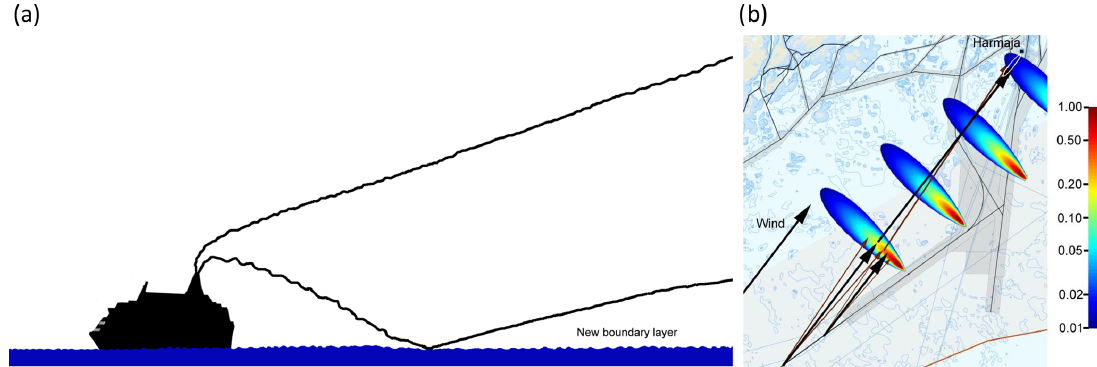
Figure 10. (a) Schematic figure of the vertical profile of ship plume dispersion. If the stack height is around 55m, the plume touches the sea surface at a distance of around 450m from the ship. Panel (b) shows the momentary plumes at 15, 23, 30, and 37 min after start (0min) at the sea surface. The black arrows are the wind speed (ws) vectors (ws = 11ms − 1 ), the brown arrows show the dispersion of the plume, and the gray lines are the ship routes to Helsinki, with one passing Harmaja Island on its right side. Note that the color bar is shown using a logarithmic scale (2 decades, highest values dark red) and refers to the pollutant concentrations in the chimney. The footprint area is shown using a white ellipsoid at Harmaja, inside of which 80% of flux is reached at the height of